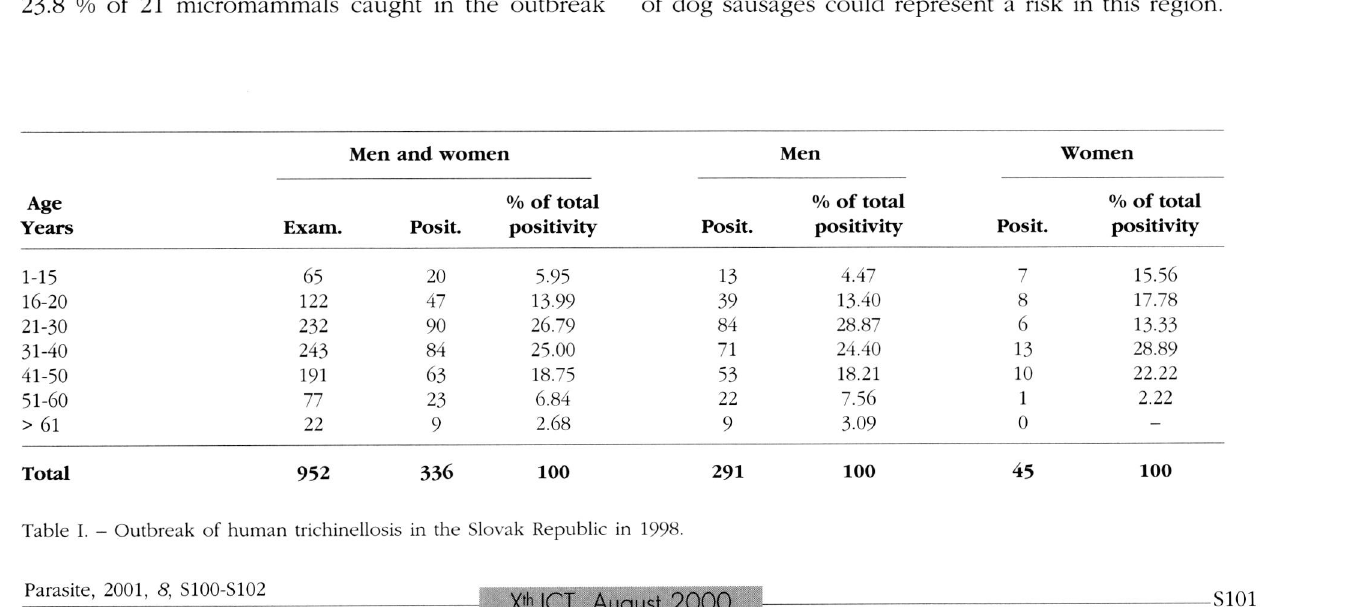
Parasite, 2001, 8,